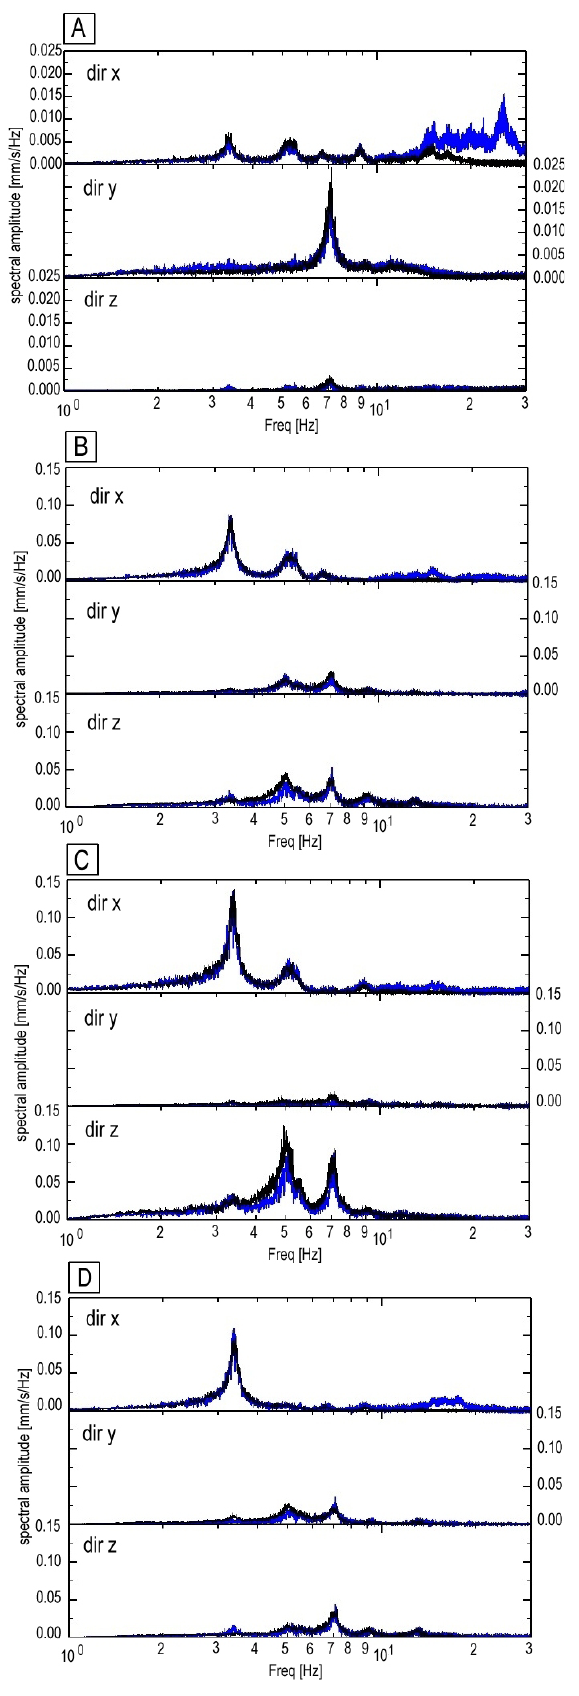
Figure 7. Semi-log plot of the spectral amplitudes of signals re- corded in sections A to D from Test 2 (black line) with sensors on the road surface, and from Test 3 (blue line) with sensors on the downstream parapet wall.